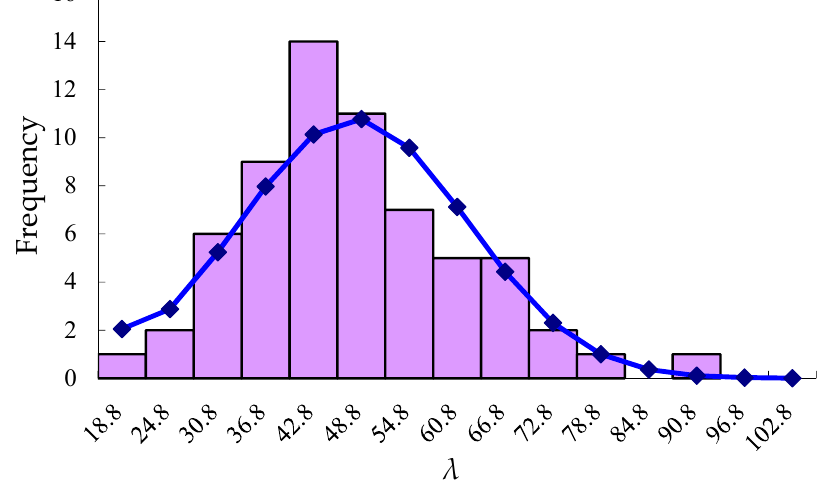
Figure 8. Statistics histogram of width-depth scaling of cracks.